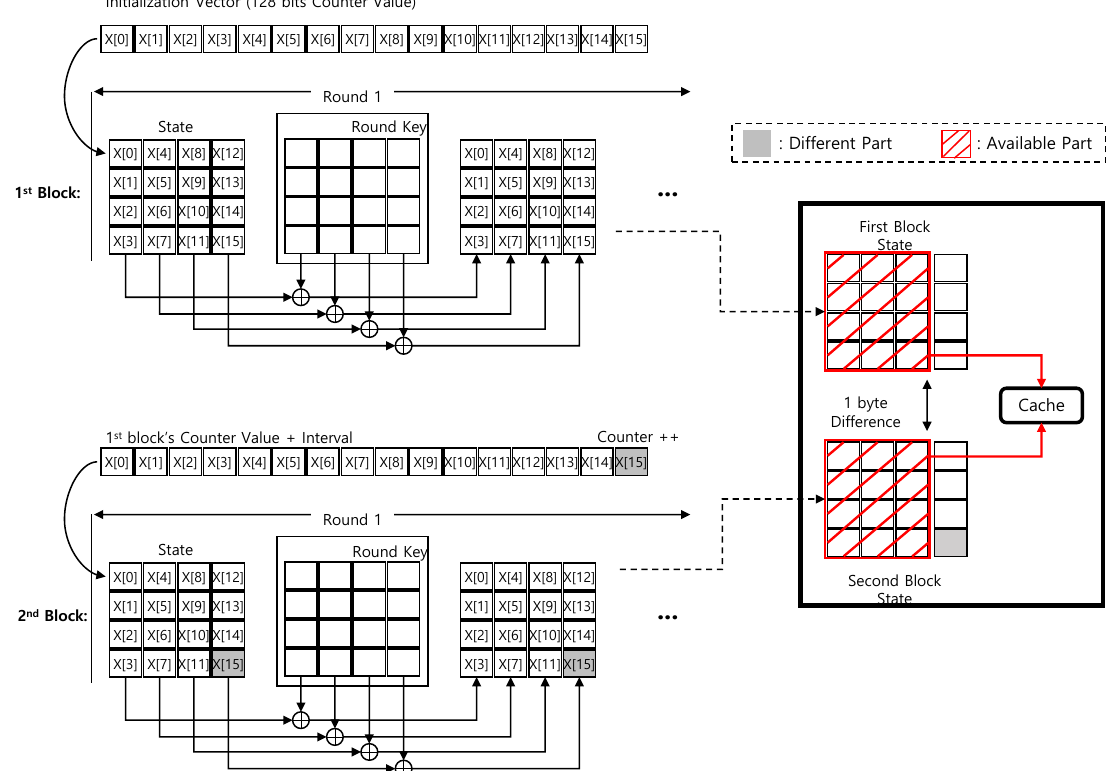
Figure 3. Difference between first and second blocks in Round 1 add-round-key of ARIA-CTR mode of operation.